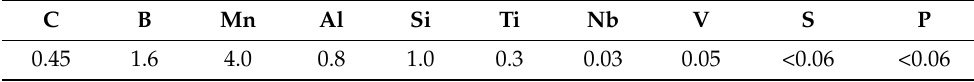
Table 1. Chemical composition of high Boron